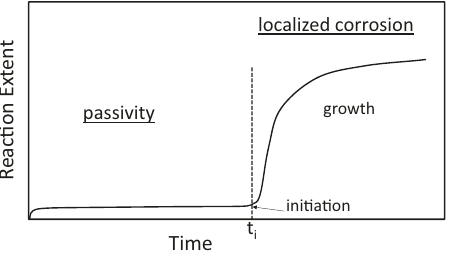
Fig. 3 Schematic of reaction rate vs. time for a CRA showing initial high rate of reaction followed by rapid slowing as passive fi lm forms and thickens. In benign environments, the passivated alloy can achieve a steady state condition with very low residual rate of reaction. However, in the presence of corrosive species such as halides, an incubation period of passivity, t i , can be followed by local breakdown of the passive fi lm and the onset of localized corrosion, leading to a rapid increase in reaction rate at local sites. The rate of growth of localized corrosion often grows as t n with n between 0.5 and